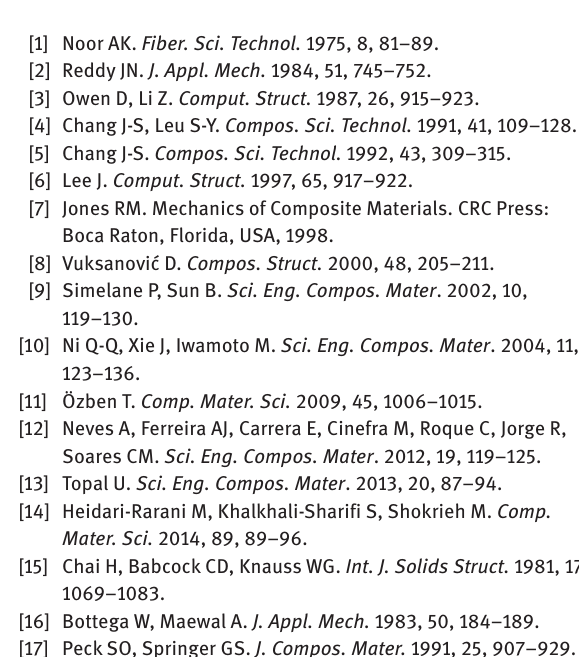
/ ± 45/90 / ± 45) rectangular laminated 2 2 s